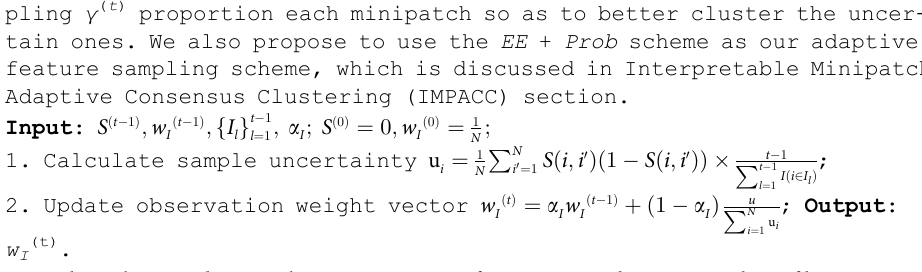
Algorithm 2: Weight updating in adaptive observation sampling